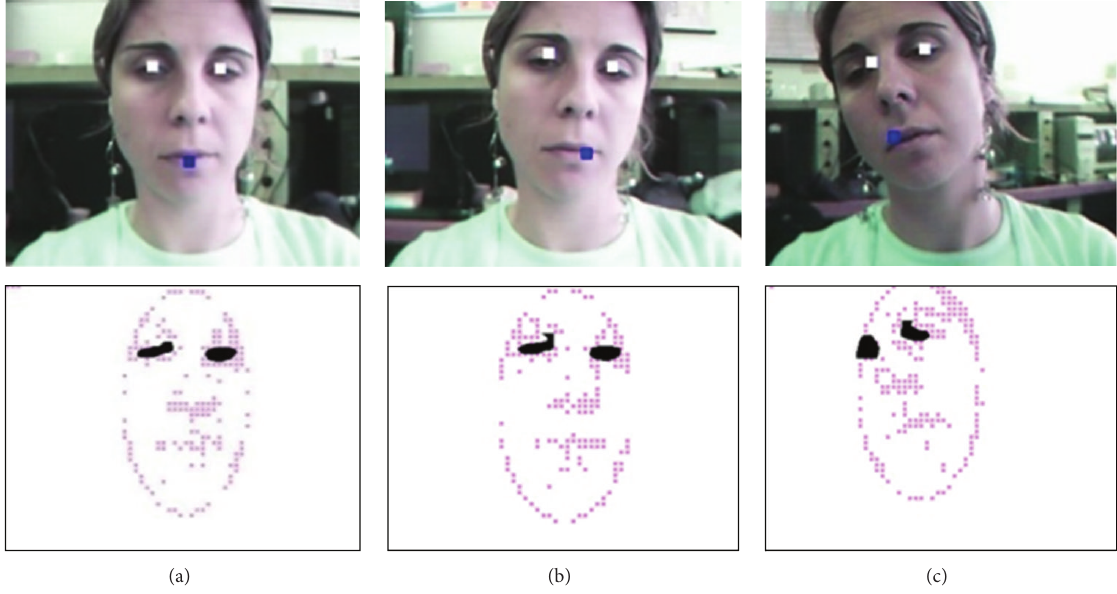
Figure 3: Examples of the facial characteristics detection. Three cases of eyes detection are shown, these case are (a) centred head, (b) head’s left-move, and (c) head’s